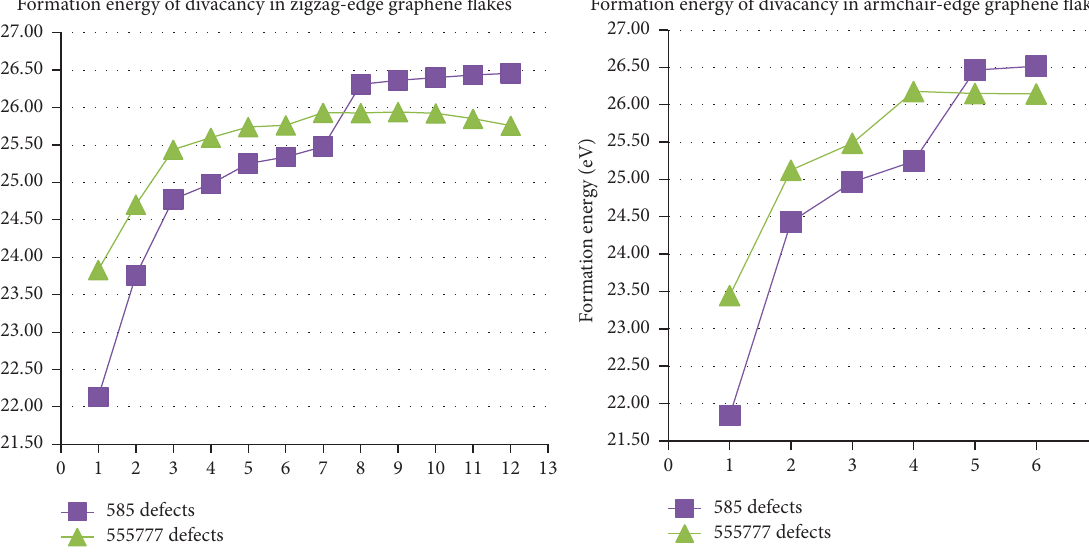
density-functional tight-binding (SCC-DFTB) method.